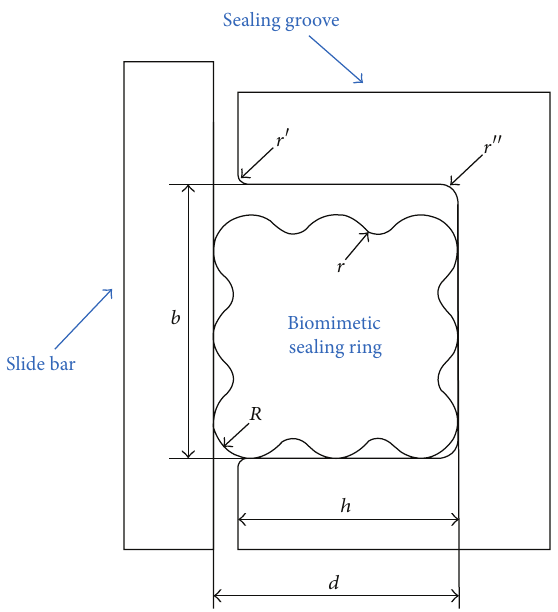
Figure 2: Schematic diagram of biomimetic sealing